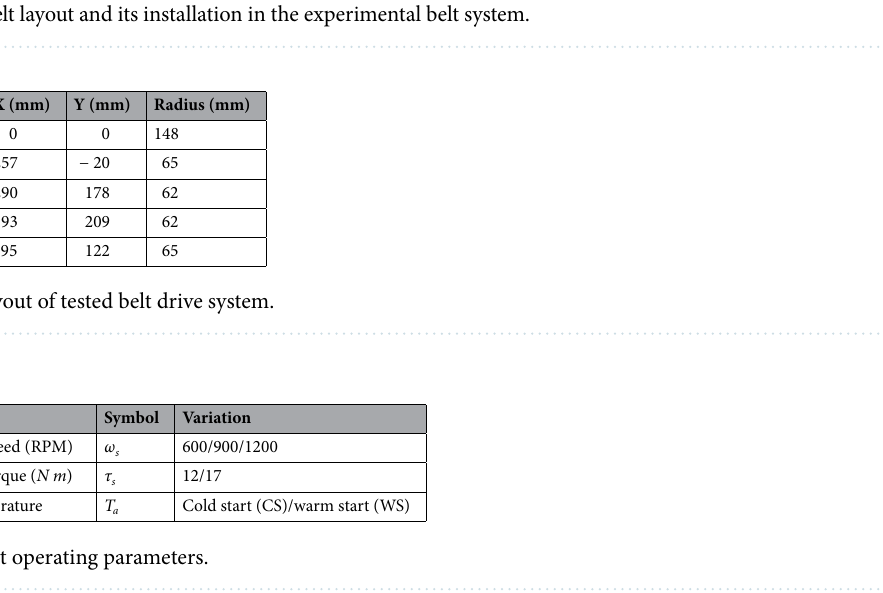
Figure 9. Belt layout and its installation in the experimental belt system.